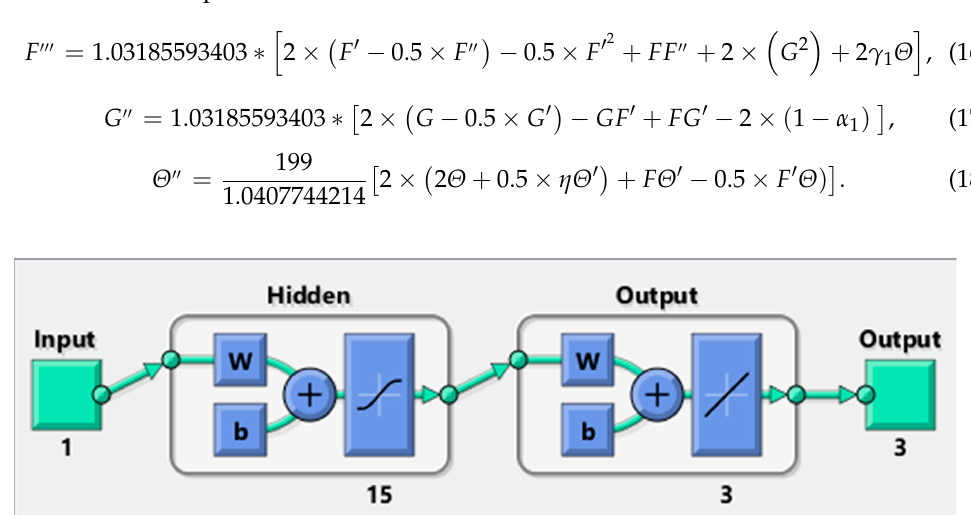
Figure 2. Networks structure of proposed ANNLMB Scheme.